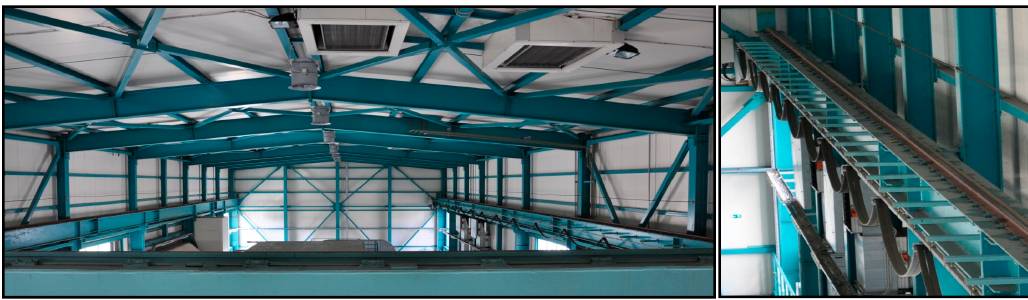
Figure 6. Crane rails in the gas block hall in the thermal power plant (TPP) in Brestanica.